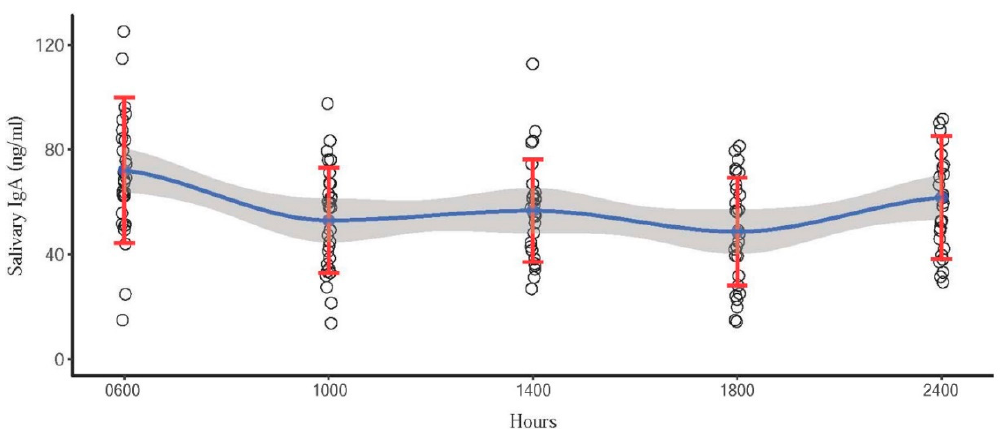
Figure 1. Scatter plot indicating quartic circadian pattern of sIgA concentrations in 10 Asian elephants. Blue dots represent the mean concentration of each time point. Red error bars represent the standard deviation. Blue line represents the trend line, and the shaded area is a 95% confidence interval of the mean.